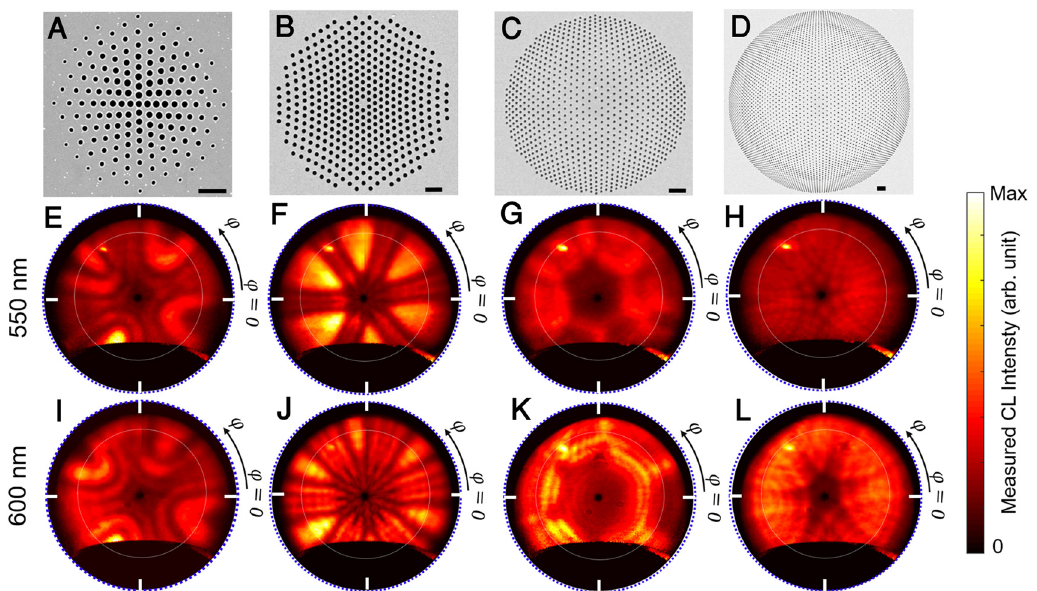
Figure11: (A – D)Scanningelectronmicroscopyimagesofdifferentfabricatedphotonsieves.(E – H)Far-fieldangle-resolvedCLmapsat550nm wavelengthwith50nmbandpass fi lterfrom(A – D)photonsieves,respectively.(I – L)Angle-resolvedCLmapsat600nmwavelengthwith50nm bandpass fi lter from (A – D) photon sieves, respectively. The inner (white) and outer (blue) circles in images (E – L) represent the θ = 60 ° and θ = 90 ° planes,respectively. The scale bar inSEM images is 1 μ m. The incident electronbeamis probed very near to the centerof each photon sieves. CL,